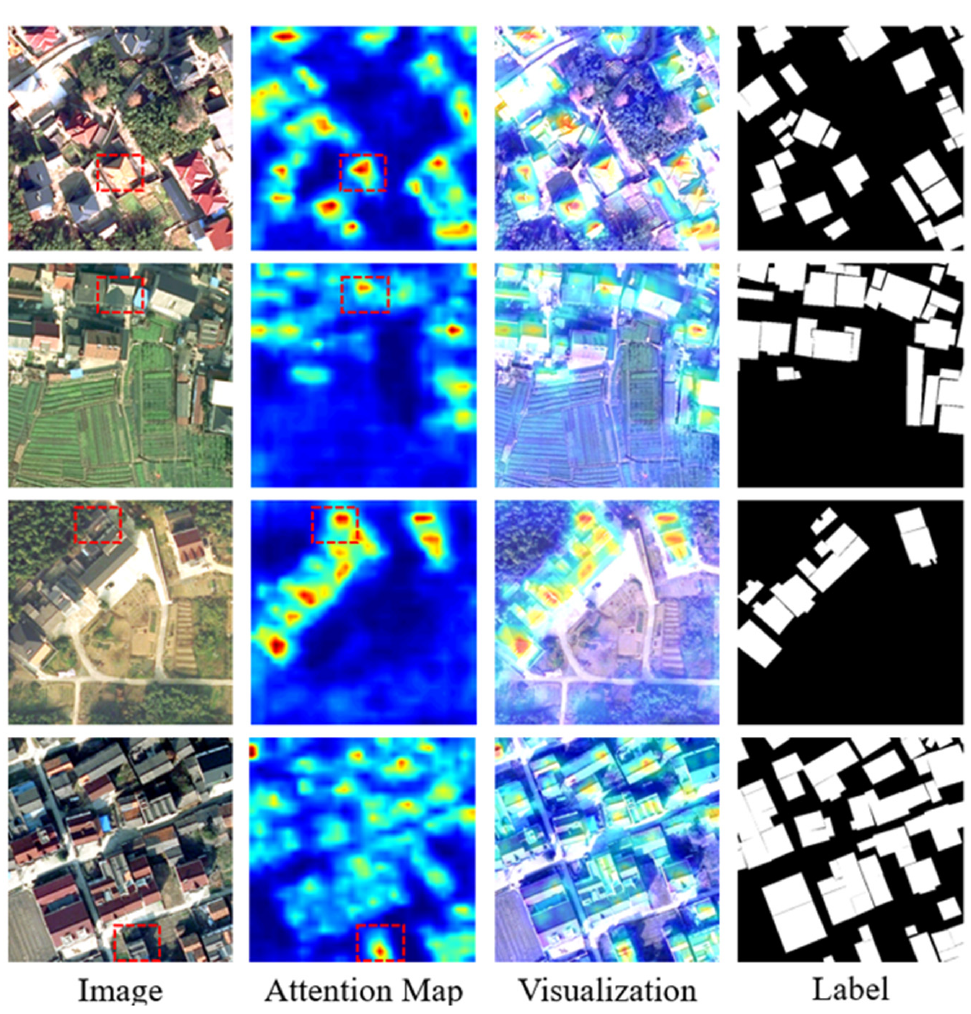
Figure 18. Visualization of mixed-scale spatial attention features.